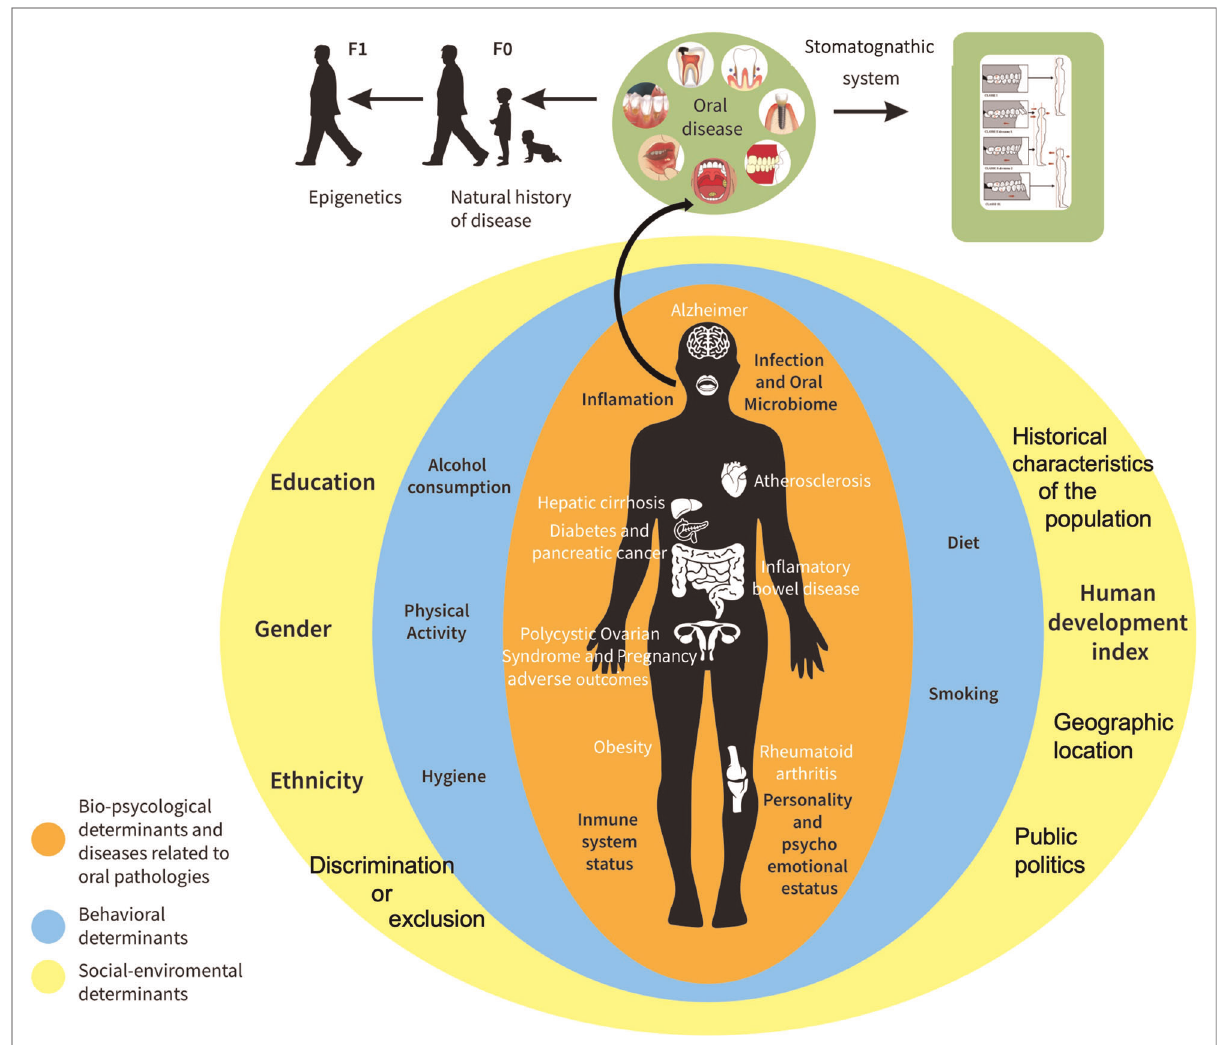
FIGURE 1 Model for holistic health through the oral cavity. The fi gure shows the interdependent relationships between general health and oral health integrated in a model of “ layers ” in which the factors/determinants that compose it interact, directly or indirectly, within and between the different levels of the organization. The fi rst layer in orange are the bio-psychological determinants and diseases related to oral pathologies; the second layer in blue are the behavioral determinants, and fi nally the third layer in yellow are the socio-environmental determinants. In addition, the model includes in green the relationship between the different oral diseases and its natural history of the disease which are heritable through epigenetics mechanisms, and the relationship of the stomatognathic system with the musculoskeletal